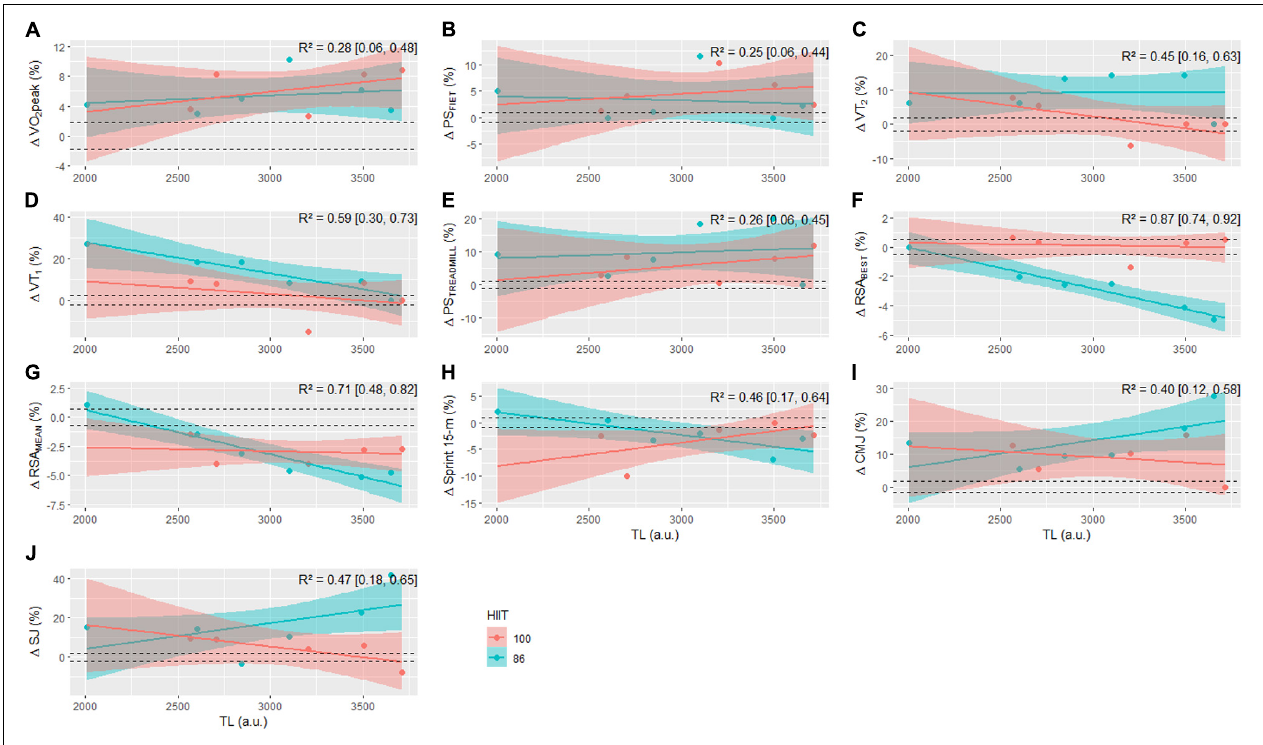
FIGURE 6 | Posterior regression medians with 90% credible intervals between pre-to-post changes in VO 2 peak (A) , PS FIET (B) , VT 2 (C) , VT 1 (D) , PS TREADMILL (E) , RSA BEST (F) , RSA MEAN (G) , Sprint 15-m (H) , CMJ (I) , and SJ (J) for each HIIT model with training load. R 2 , Bayesian variance explained. Horizontal dashed lines are the lower and upper boundaries of the ROPE (i.e., 0.2 × between subjects